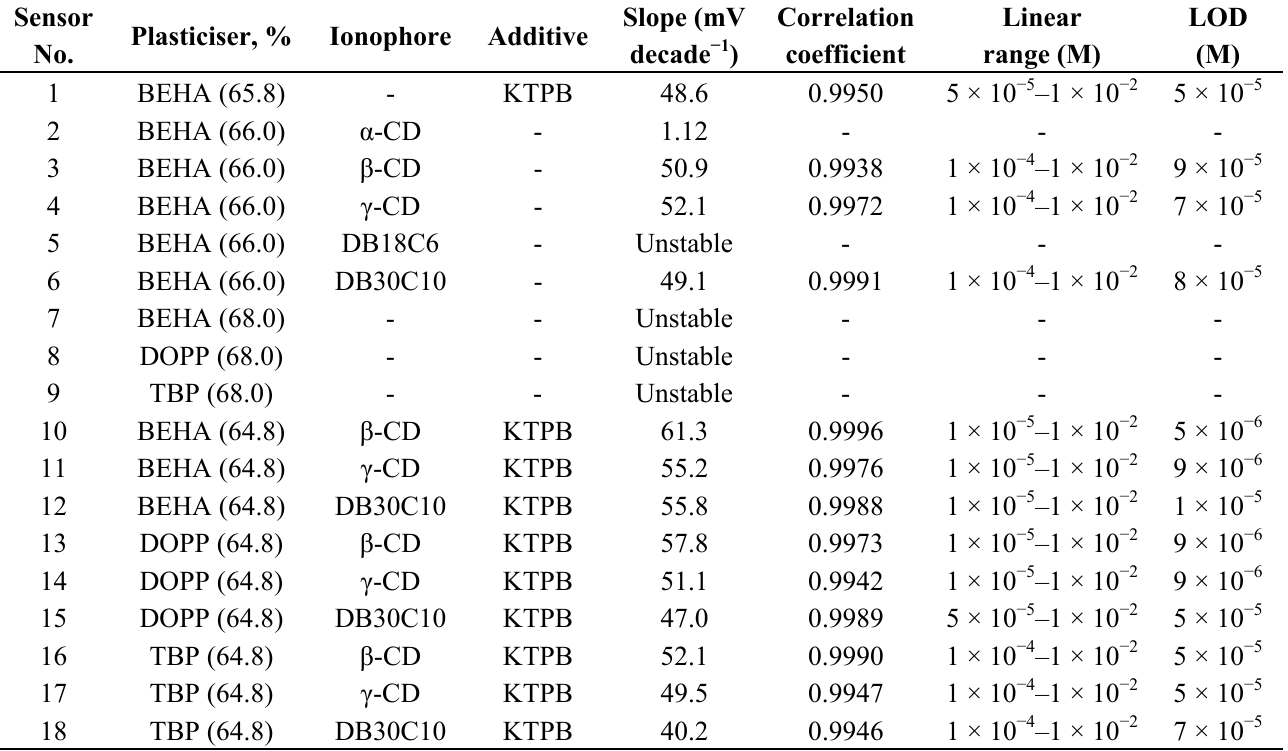
Table 1. Effect of membrane composition on the characteristics of promethazine sensors.